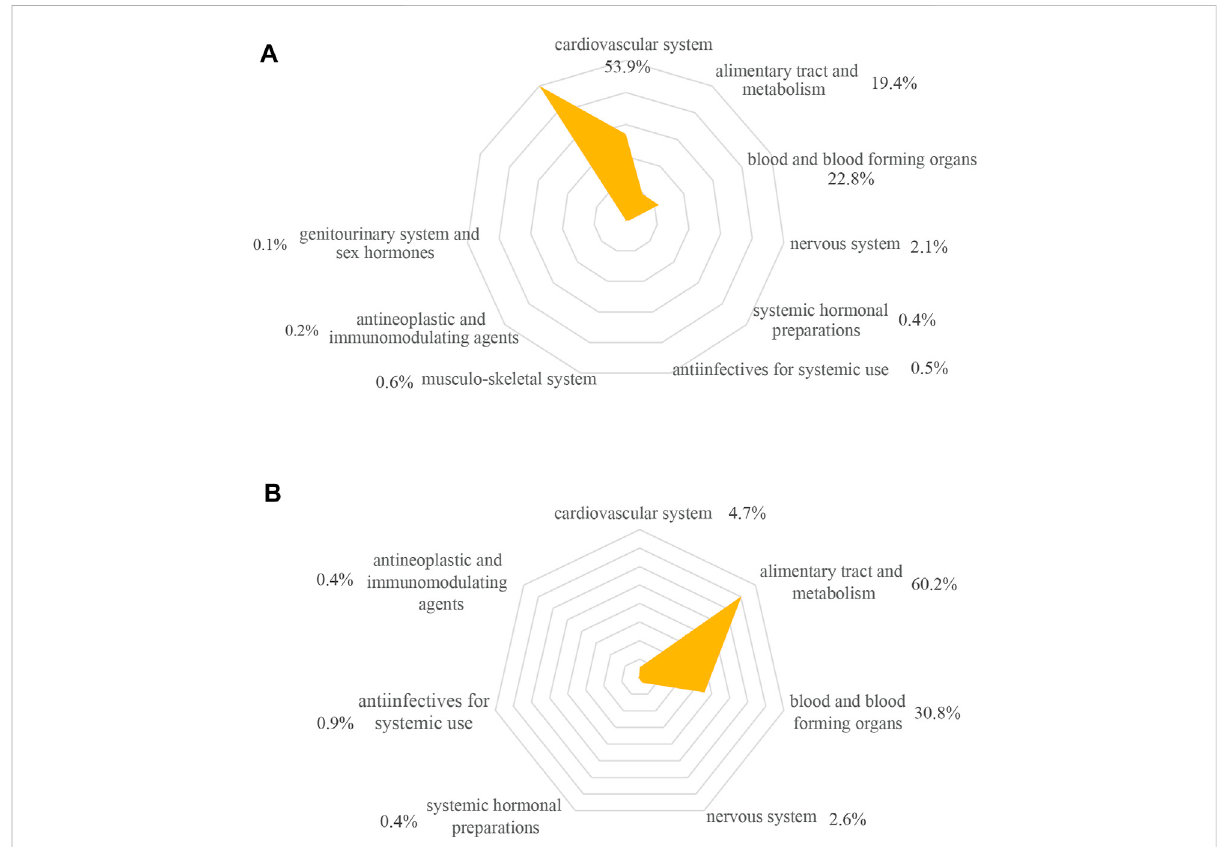
FIGURE 2 ATC classi fi cation-wise distribution of pDDIs. (A) category C ( n = 1,494); (B) category D and X ( n = 234). Percentage was calculated out of number of pDDIs in each risk category. pDDIs, potential drug-drug